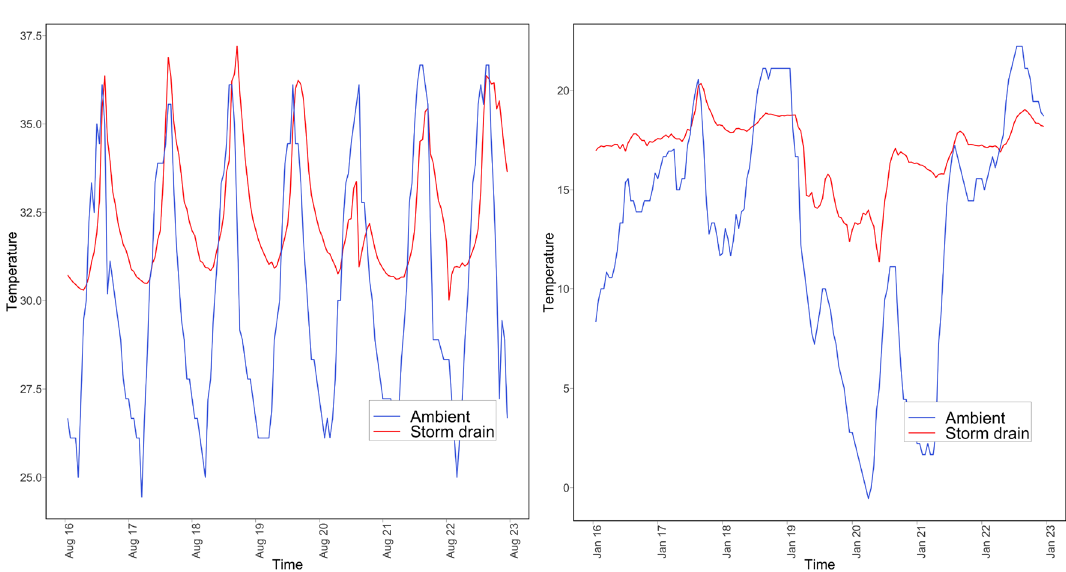
Figure 4. Ambient versus microclimatic temperatures in storm drain location (L) in August (R) in